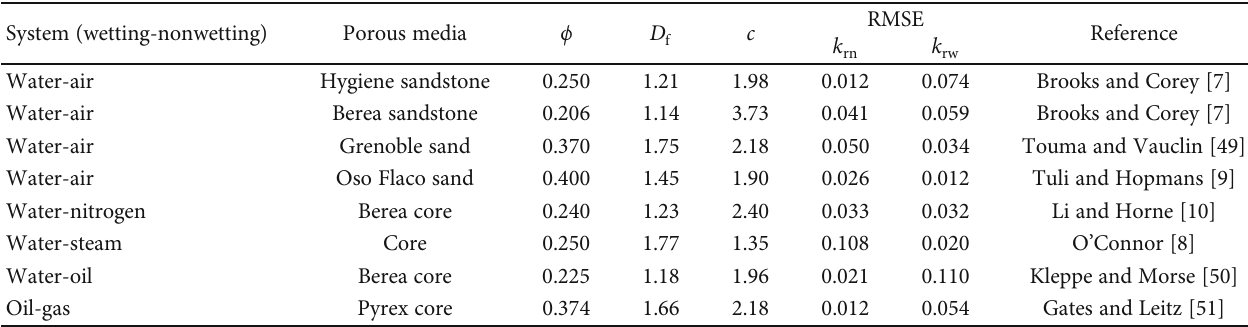
Figure 3: The predicted permeability-porosity curve and the comparison to the KC equation and measured data. Table 2: The pore structure parameters of porous media and the corresponding